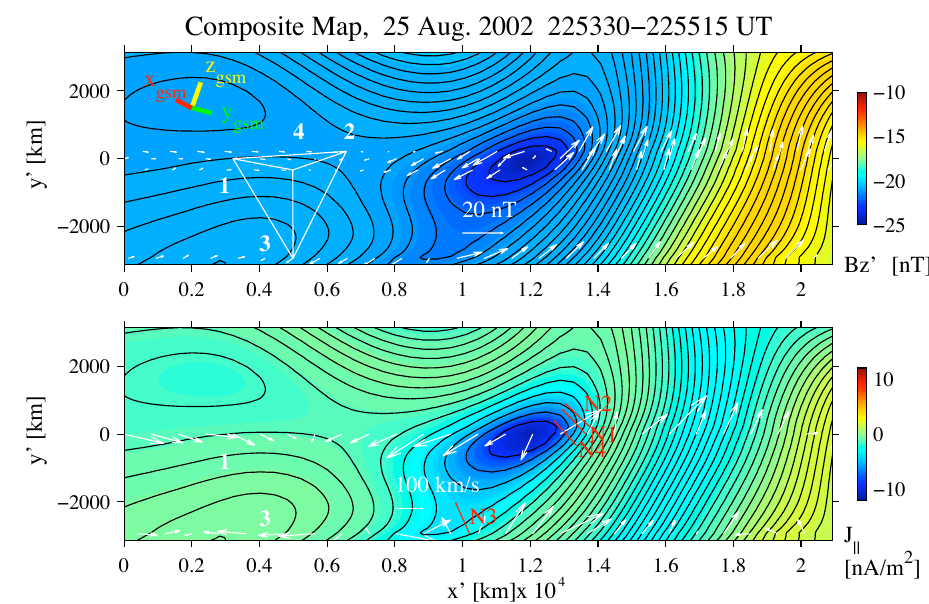
Fig. 3. Grad Shafranov reconstruction of the boundary of the BBF. Top panel: Map of the magnetic field. Black lines show magnetic line contours in the reconstruction plane and the color indicates the out-of-plane component of the B -field (negative into the plane). White arrows show the measured magnetic field along the trajectories of the four spacecraft. Bottom panel: Similar to top panel, but the color now indicates the out-of-plane current density (positive into the plane) and the white arrows indicate measured flow velocities, relative to the GS frame. Red arrows show boundary normals obtained as described in Sect. 3.2. The center of the maps reveal an about 2500 × 5000km structure with a helical like magnetic field topology and a strong field aligned current component. The coordinate system in this figure is not GSM, but uses optimally selected axes for the reconstruction. The orientation of the GSM coordinates is indicated in the upper panel and also listed in Table 1.